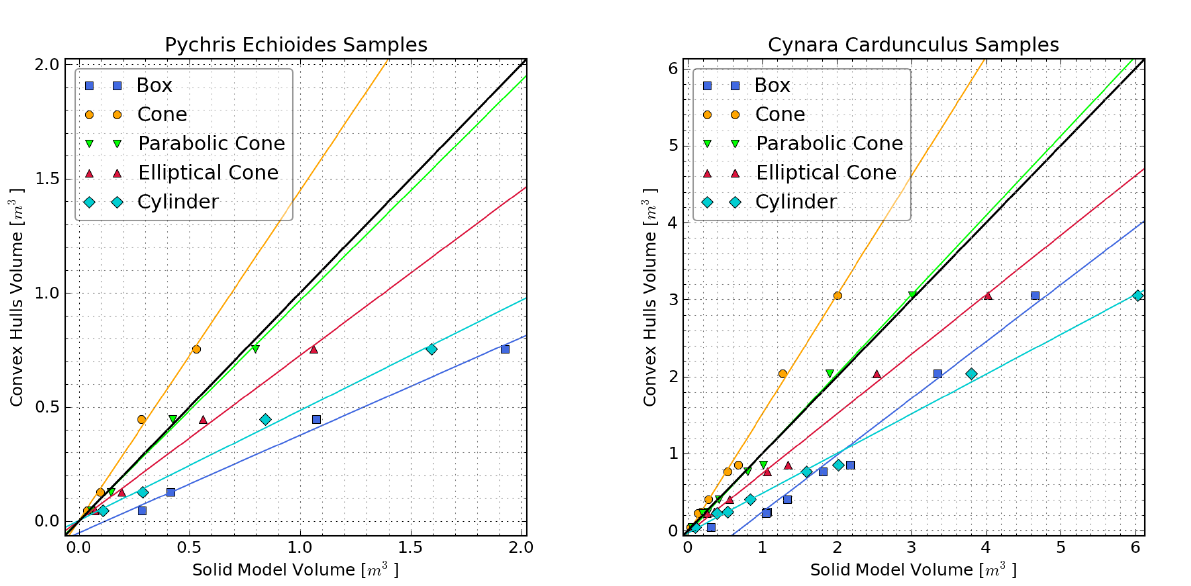
Figure 5. Direct comparison of volumes obtained from convex hulls and those derived from manual measurements with various solid shape approximations. Solid lines represent least squares linear